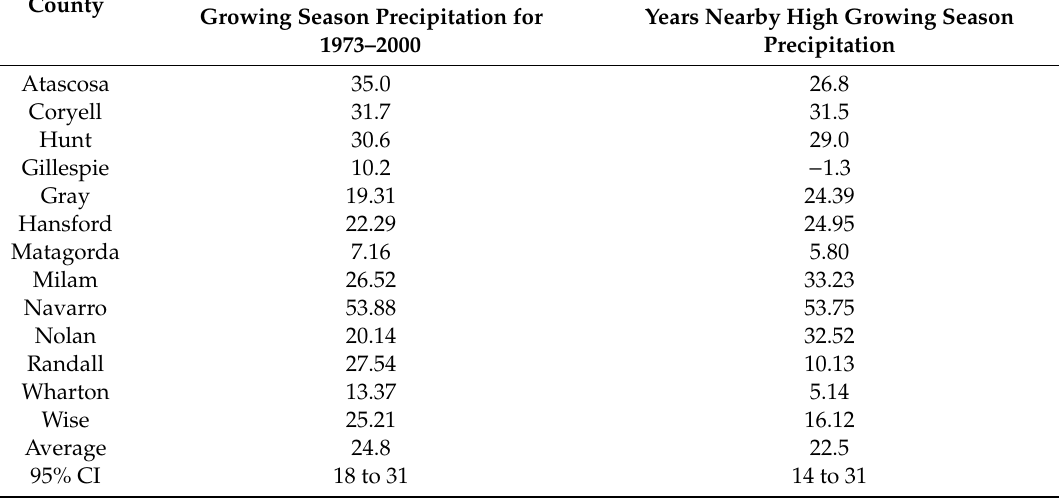
Table 4. Di ff erences in sorghum yield between maximum 4-day precipitation (for years 1973–2000) and years showing high growing season total precipitation and years nearby high growing season total precipitation (Level 3